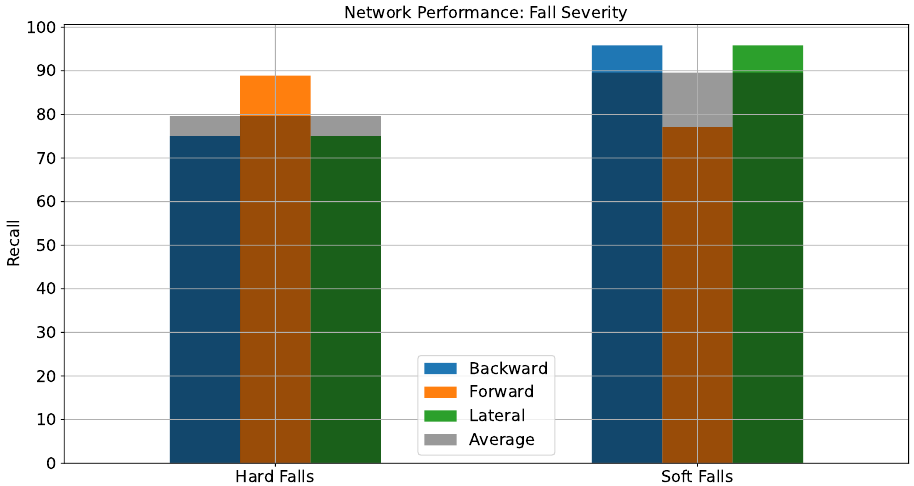
Figure 5. Network performance for different fall